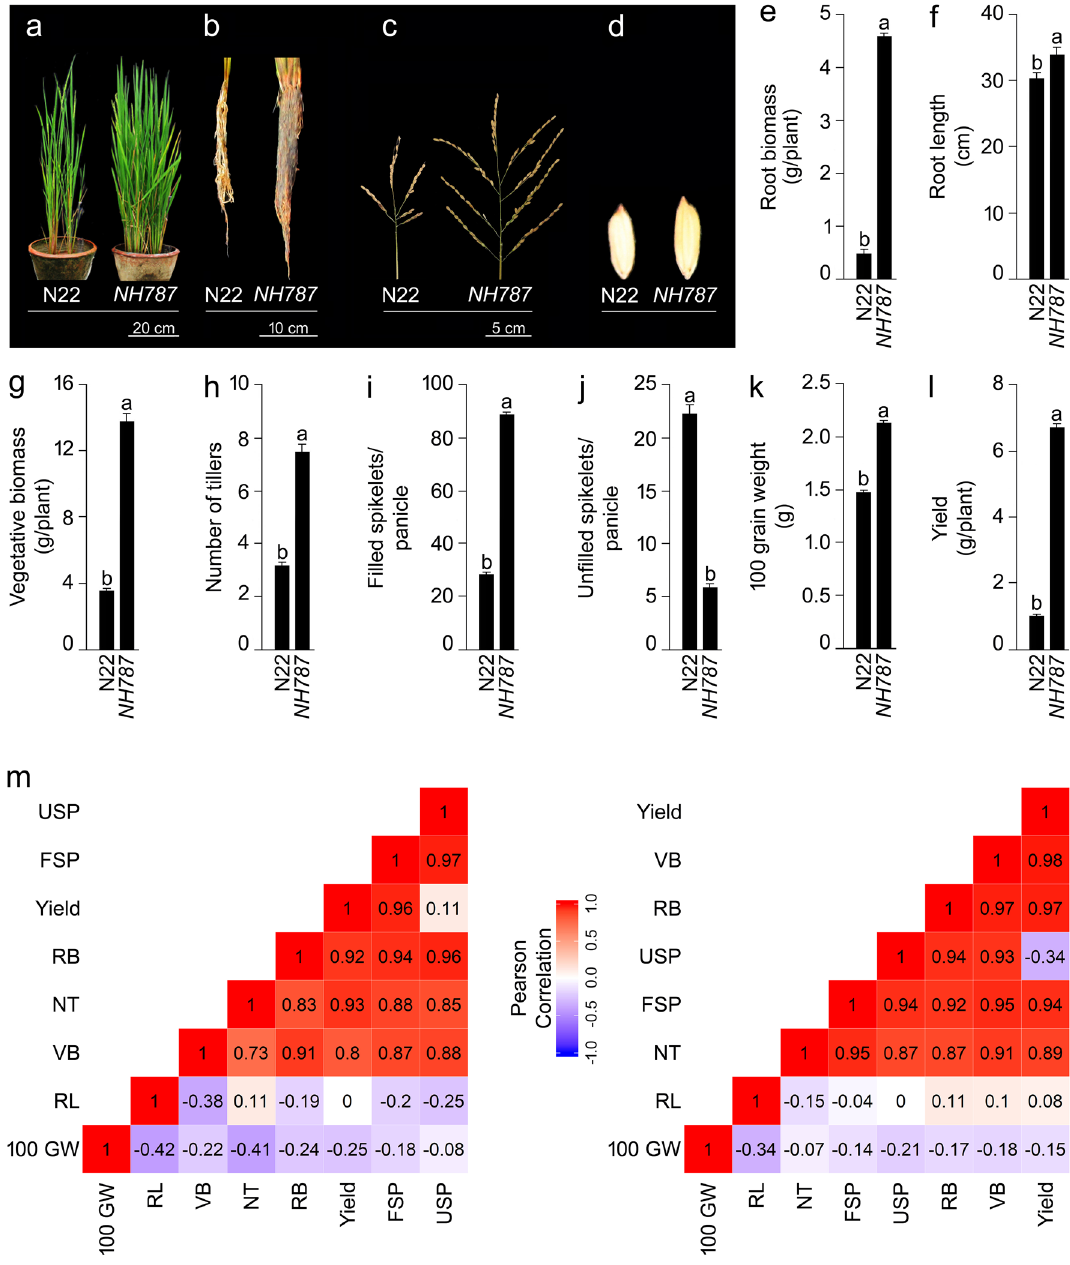
Figure 3. Effects of Pi deficiency on the growth performance and agronomic traits. N22 and NH787 seedlings (15-day-old) were grown in a low Pi (P−) potting soil up to maturity. ( a – d ) Growth performance ( a ) and phenotype of the root ( b ), panicle ( c ), and seed ( d ) of Pi-deprived N22 and NH787. The photographs ( a – d ) are representatives of 12 independent biological replicates. ( e – l ) Data presented for ( e ) root biomass, ( f ) root length, ( g ) vegetative biomass, ( h ) number of tillers, ( i ) filled spikelets/panicle, ( j ) unfilled spikelets/panicle, ( k ) 100- grain weight, and ( l ) yield. Values ( n = 12) are means ± SE and different letters on the histograms indicate that the means differ significantly ( P < 0.05). Correlogram of agronomic traits i.e., filled spikelets/panicle (FSP), number of tillers (NT), root biomass (RB), root length (RL), vegetative biomass (VB), unfilled spikelets/panicle (USP), and 100-Grain weight (100 GW) in Pi-deprived N22 and NH787. The scale represents Pearson correlation values with reddish and bluish shades indicate positive and negative correlation,